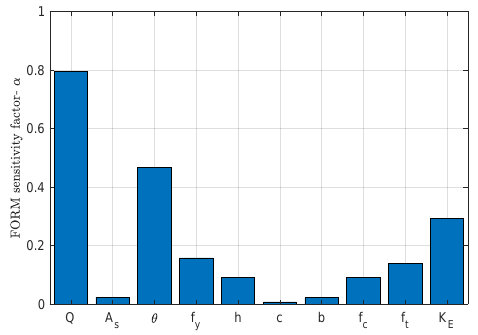
Figure 6. First order reliability method (FORM) sensitivity factors of the stochastic basic variables. Deterministic basic variables have FORM α values of